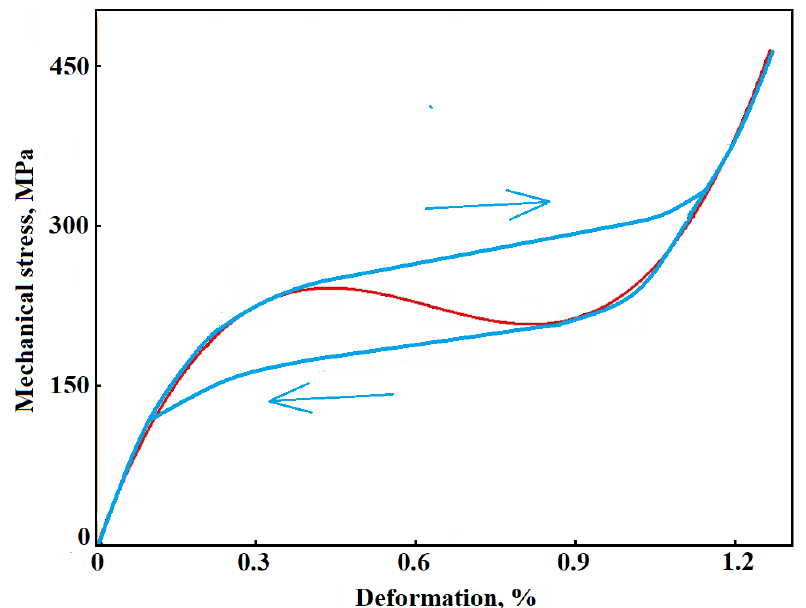
Figure 9. The effect of superelasticity: the red line is the theoretical curve, the blue line is the expected experimental curve (arrows show the directions of the stress change).